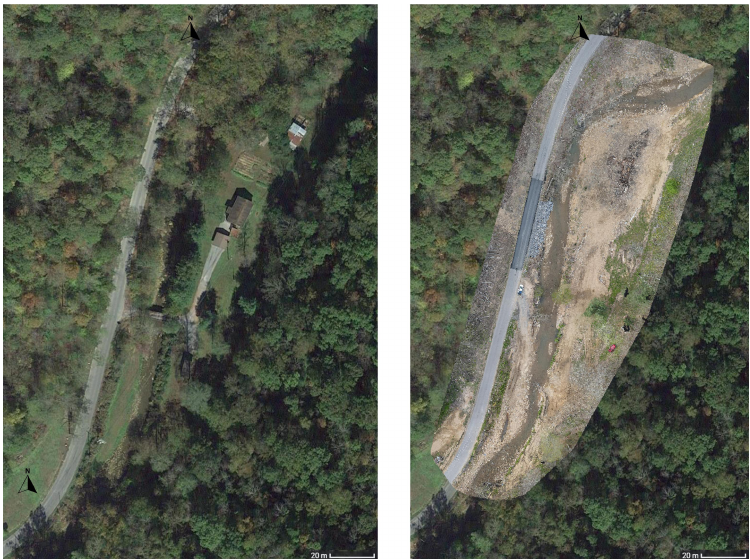
Figure 7. A comparison of pre-flood satellite imagery to post-flood imagery. The image on the left shows Google Maps satellite imagery. The image on the right shows the post-flood orthophoto overlaid on the satellite image in GIS